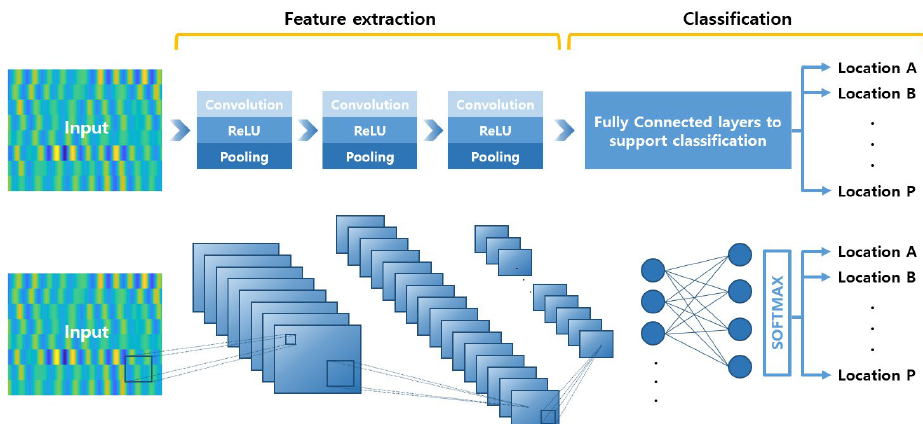
Figure 1. Convolutional Neural Network architecture for image classification.